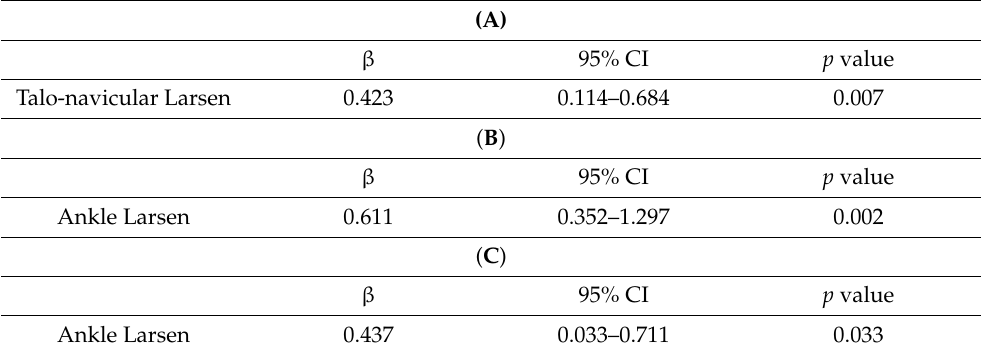
Table 5. Correlation coefficients between mid-hindfoot joint destruction and other parameters on multivariable linear regression analysis. ( A ) Correlation coefficients between Ankle Larsen and other parameters. ( B ) Correlation coefficients between Talo-navicular Larsen and other parameters. ( C ) Correlation coefficients between Subtalar Larsen and other